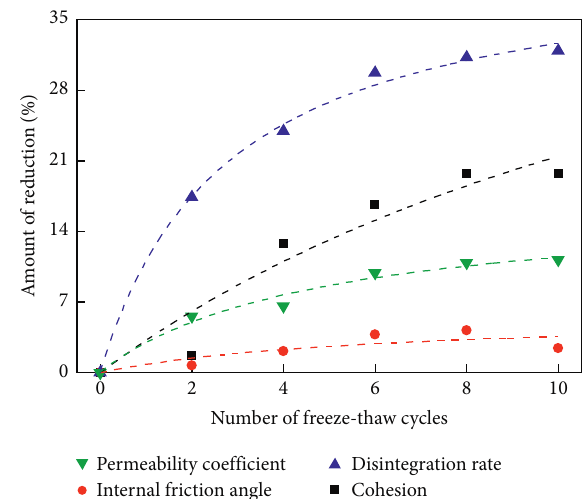
Figure 9: The effects of F-T cycles on reduction of the antierosion ability parameters with the number of cycles.